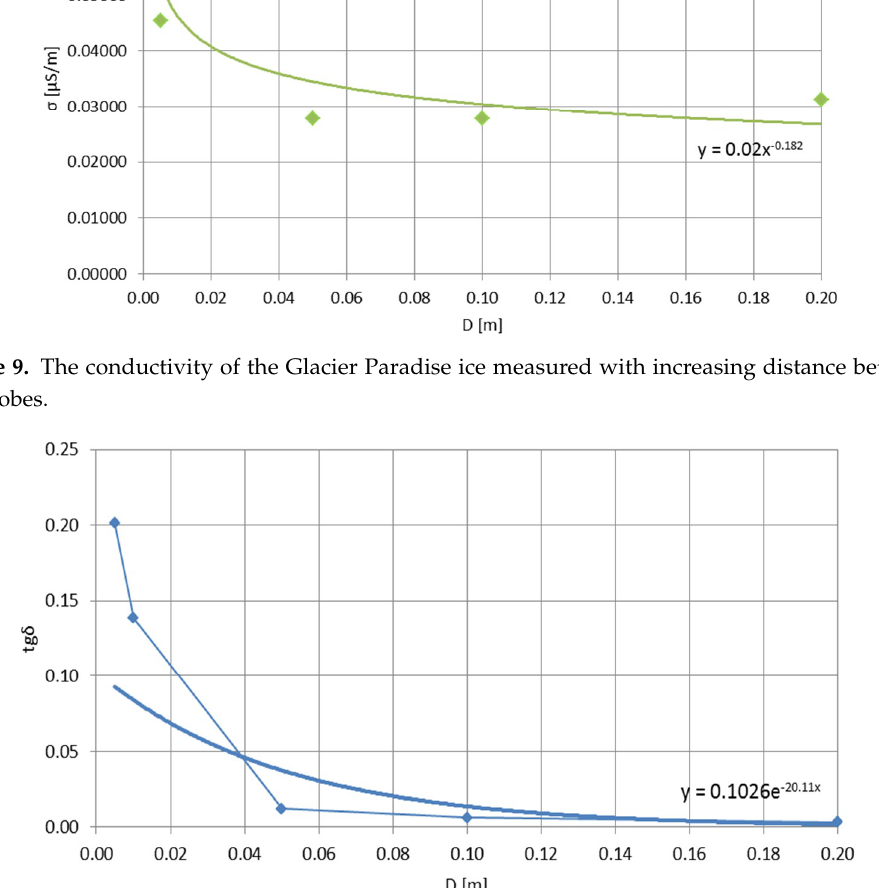
Figure 10. The tangent of loss angle of the Glacier Palace ice in relation to the distance between the spike probes; the thick line represents the approximated exponential function, the open polygon shows the actual decrease of values for comparative